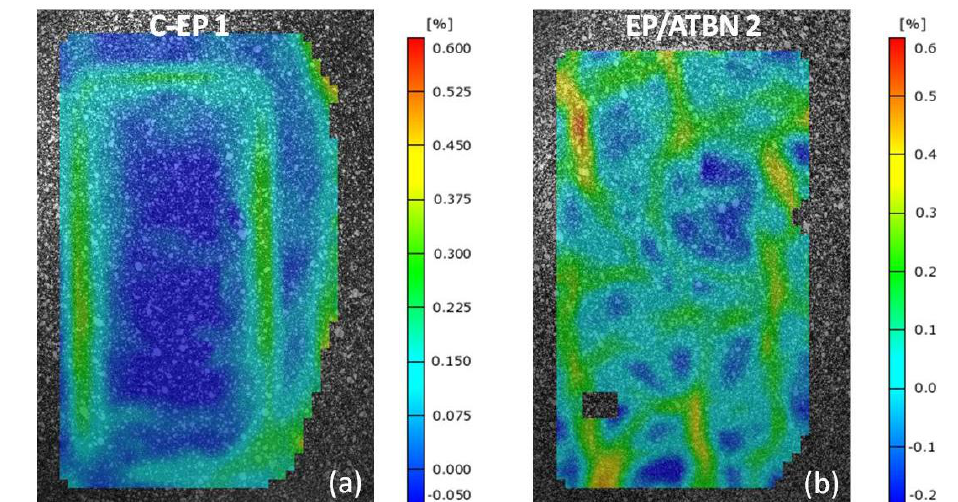
Figure 6. Major strain distribution, testing plate with 30 mm slot at a pressure of 1 MPa. ( a ) Material C-EP 1; ( b ) Material EP/ATBN